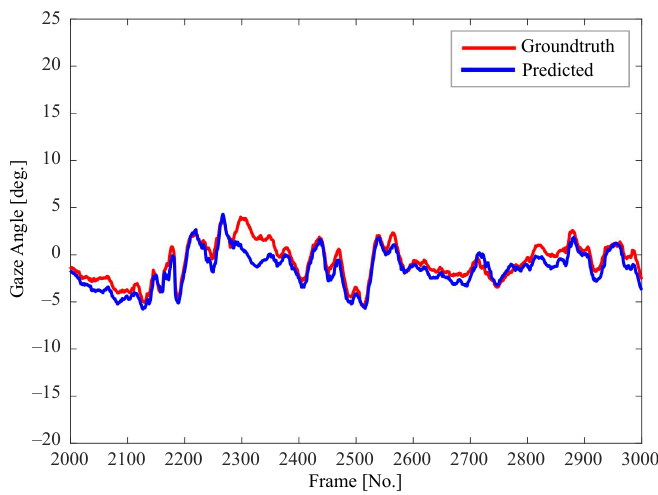
Roll Figure 9. Comparison between the predicted value and the ground-truth value of roll